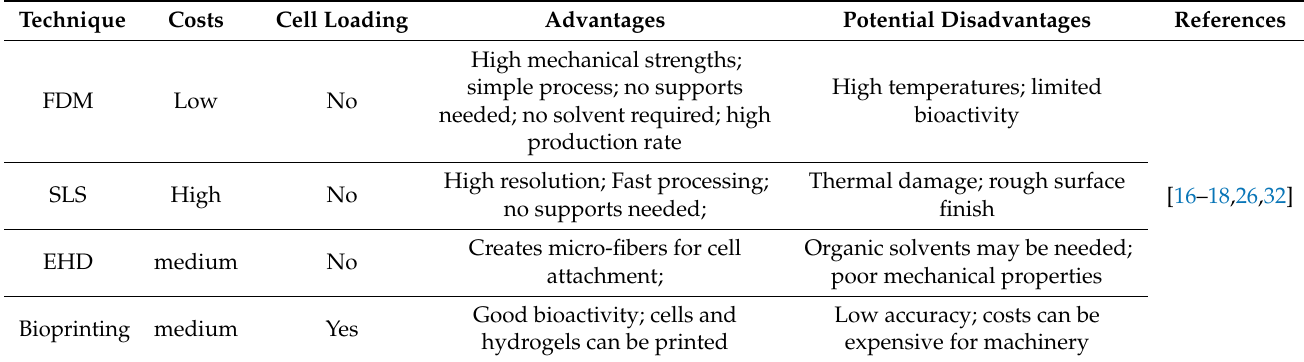
Table 1. Comparison of 3D printing technique for PCL-based scaffold